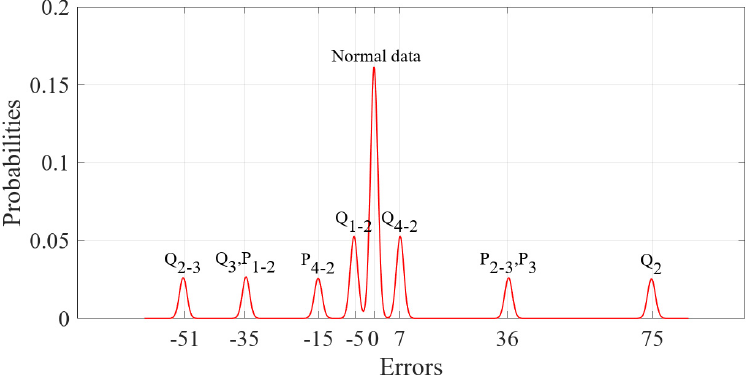
Figure 16. PDF of measurement errors.